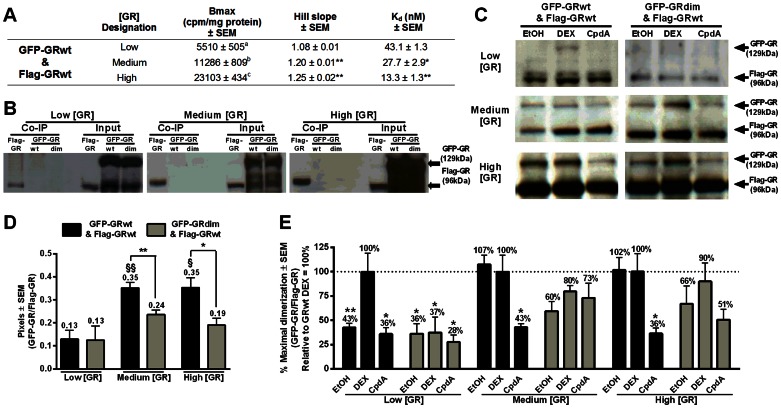
Ligand-independent dimerization of GRwt increases significantly at GR concentrations displaying cooperative ligand-binding.COS-1 cells were transiently transfected with GFP-GRwt and Flag-GRwt at low, medium or high levels. (A) Summary table of GFP-GRwt and Flag-GRwt saturation binding results. Statistical analysis of maximal binding (Bmax) compared to GRwt levels (Fig. 2C) was carried out using one-way ANOVA followed by Newman-Keuls post-test. Conditions with different letters are statistically different from one another (P<0.01). Statistical analysis of Hill slope and Kd against the low GR concentration condition were carried out using one-way ANOVA followed by Newman-Keuls post-test (P*<0.05, P**<0.01). Results represent a minimum of two independent experiments performed in triplicate (±SEM). (B–E) Co-IP was performed on COS-1 cells expressing low, medium or high concentrations of GFP-GRwt and Flag-GRwt or GFP-GRdim and Flag-GRwt using anti-flag beads to precipitate flag-tagged proteins. Precipitated fractions were analyzed with immunoblotting with an anti-GR antibody. Flag-GR and GFP-GR concentrations were quantified using UN-SCAN-IT software. GFP-GR pull down was then normalized over Flag-GR levels. (B) Co-IP controls and their inputs containing Flag-GRwt or GFP-GRwt or GFP-GRdim only at low, medium or high concentration. Cells were induced for 1 hour with 10−6 M DEX. (C) Co-IP after induction with ethanol (EtOH), 10−6 M DEX or 10−5 M CpdA for 1 hour. (D) Quantification of ligand-independent (EtOH) dimerization. Statistical analysis was through two tailed unpaired t tests of GRwt against GRdim (*P<0.05) and one-way ANOVA followed by Dunnett's post-test against low GR concentration within GRwt (§P<0.05, §§P<0.01) or GRdim populations. (E) Normalized GFP-GR pull down, following induction with with ethanol (EtOH), 10−6 M DEX or 10−5 M CpdA, was expressed relative to DEX GRwt set at 100 percent, at each receptor level. Statistical analysis was carried out using ANOVA followed by Dunnett's post-test against DEX stimulation of GRwt at each receptor level (P*<0.05, P**<0.01). Results in (D) and (E) are representative of three independent experiments (±SEM).